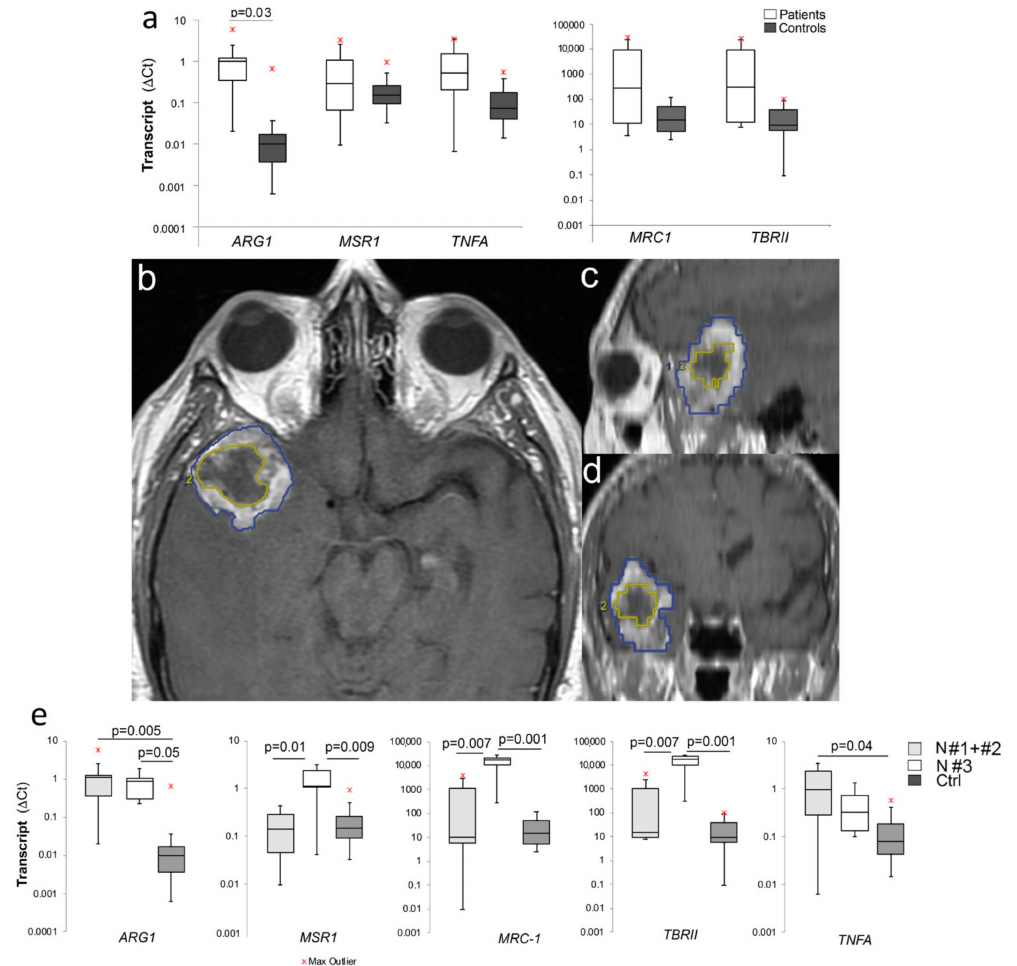
Figure 1. M2 gene expression profile in peripheral blood of glioblastoma (GBM) patients ( a ) Box plots of ARG1, MSR1, MRC1, TBR II, and tumor necrosis factor- α (TNFA) transcript levels in RNA extracted by 11 patients and 9 healthy donors’ peripheral blood mononuclear cells (PBMCs). ( b – d ) T1 TSE post-gadolinium images, axial section ( b ), and sagittal ( c ) and coronal ( d ) plane reconstructions: Region of interest (ROI) 1 (blue) indicate the tumor volume, ROI 2 (yellow) the necrosis volume. ( e ) MSR1, MRC1, TBR II, and TNFA transcript levels according to the necrosis score (N#3 = 4, N#1 + #2 = 8). Graphs were generated using Microsoft Excel.app